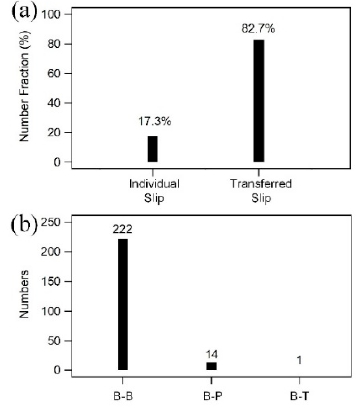
Figure 7. ( a ) The number fractions of grains with slip traces observed, and ( b ) the number of grains with different transferred slip modes observed (94% are B–B).